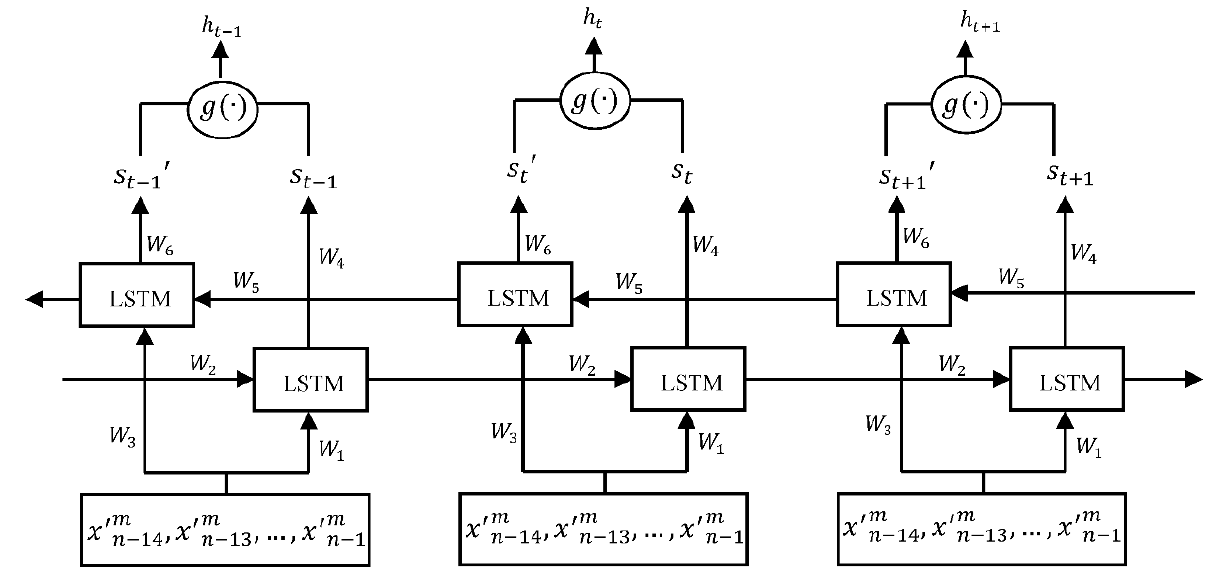
Figure 5. Bi-LSTM structure.